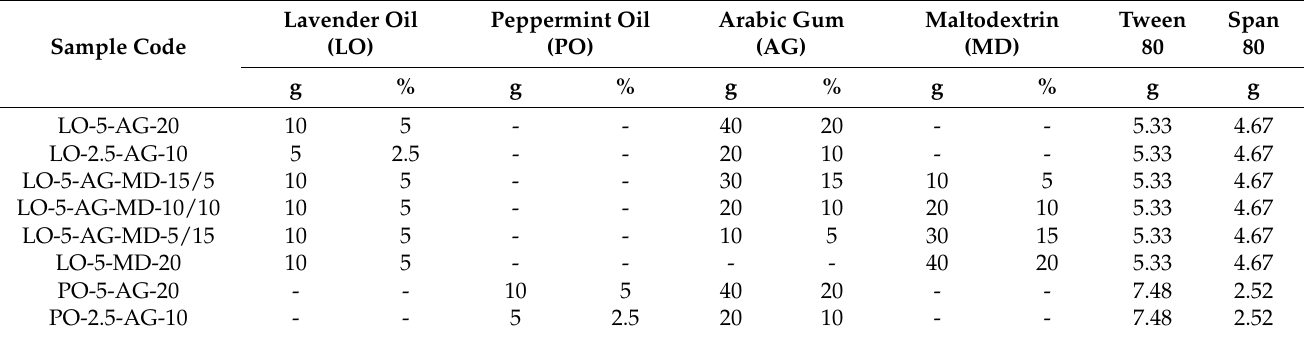
Table 1. Experimental design of emulsions for